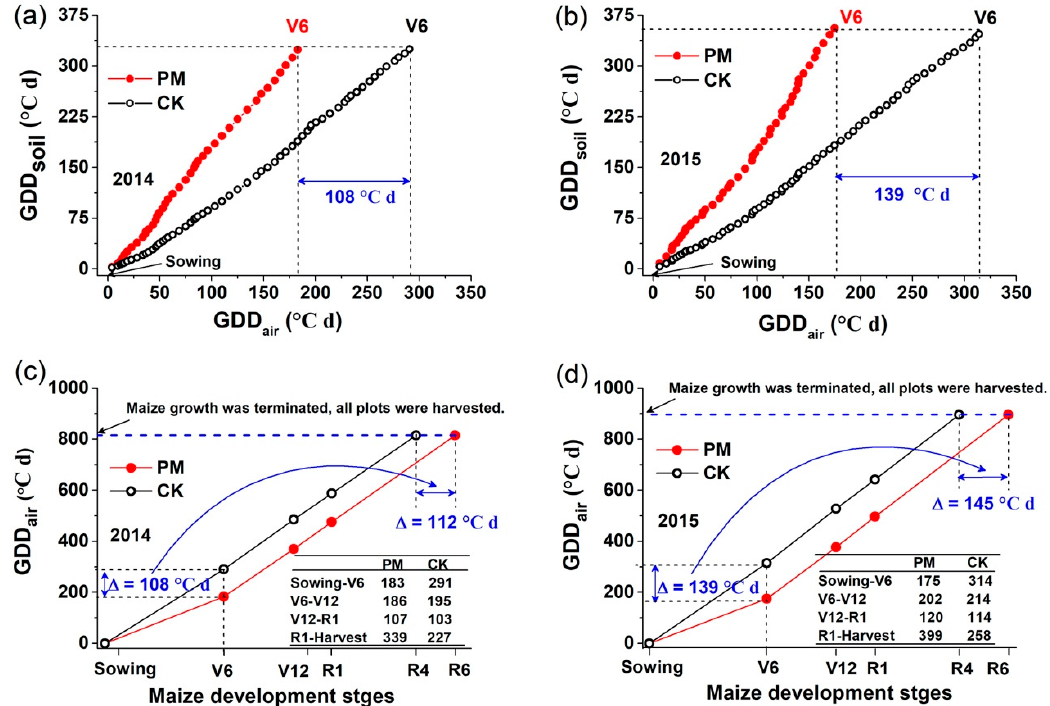
Figure 7. The relationship between air temperature growing degree days (GDD air ) and soil temperature growing degree days (GDD soil ) ( a , b ), and the distribution of GDD air ( c , d ) in the mulched (PM) and check (CK) plots during the corn growing period in 2014 (left column) and 2015 (right column). V6: six-leaf stage, V12: twelve-leaf stage, R1: silking stage, R4: dough stage, R6: physiological maturity, and ∆ : the di ff erence in GDD air between PM and CK. Inset ( c , d ): The GDD air during four periods. The blue curve arrow ( c , d ) indicates the saved GDD air in PM before stage V6 that will be used for reproductive growth, as the higher soil temperatures in PM accelerated the accumulation rate of GDD soil and decreased the consumption of the corresponding GDD air ( a , b ). The blue dashed line in ( c , d ) indicates when corn growth terminated; plants in PM had reached R6, while those in CK had only reached stage R4, and had no mature grains due to the rapidly falling air temperature. All plots were harvested at the same time and had the same total GDD air .